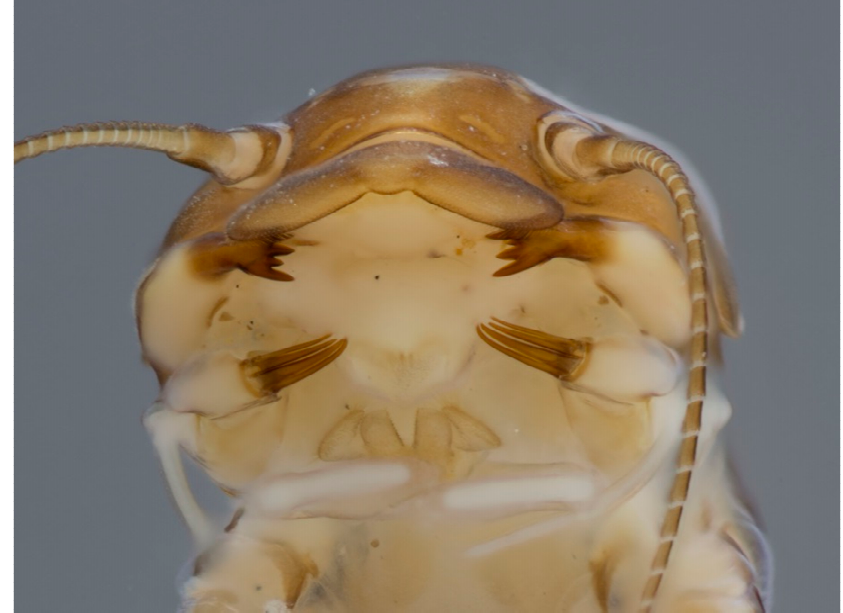
Figure 11. Guloptiloides gargantua Gattolliat & Sartori (Baetidae, Madagascar) details of the head in ventral view; mandibles and maxillae blade-like to prey mainly on other baetid larvae.